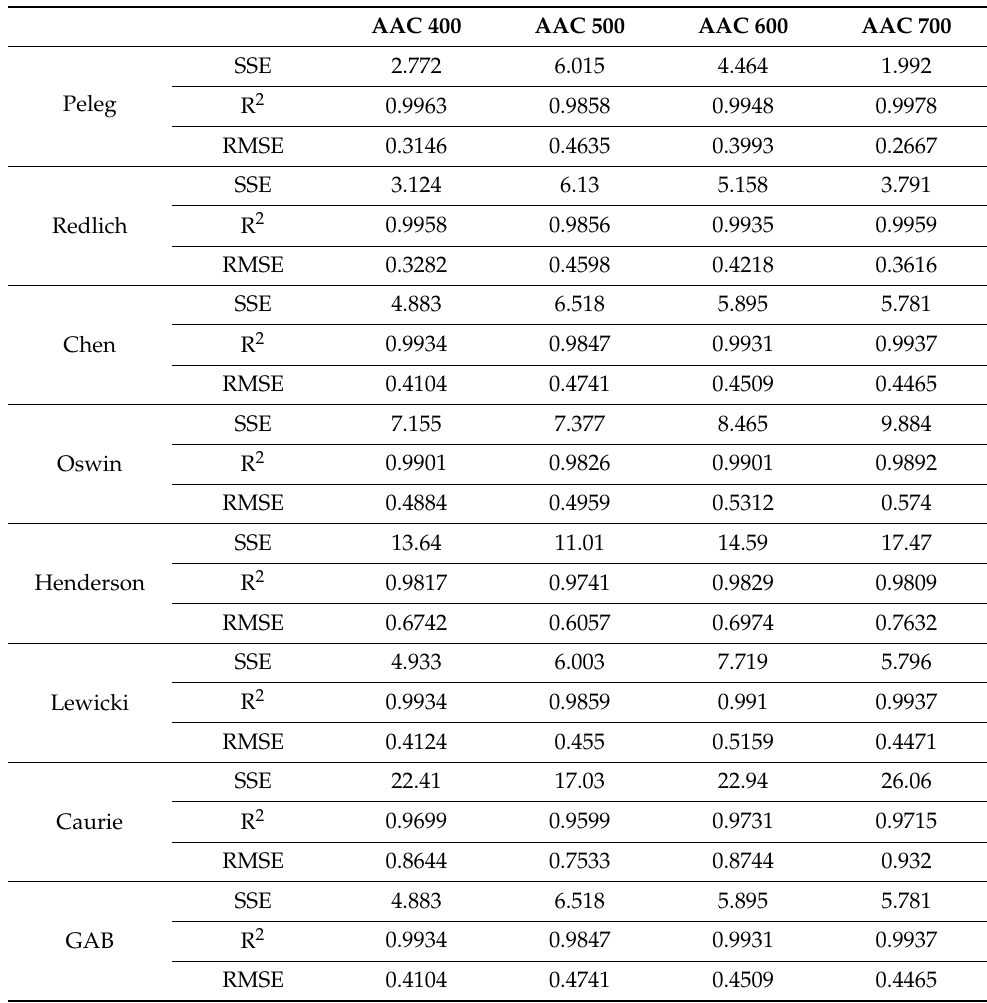
Table 5. Summary of SSE, R 2 , and RMSE approximation parameters for the analyzed models and the tested aerated concretes.